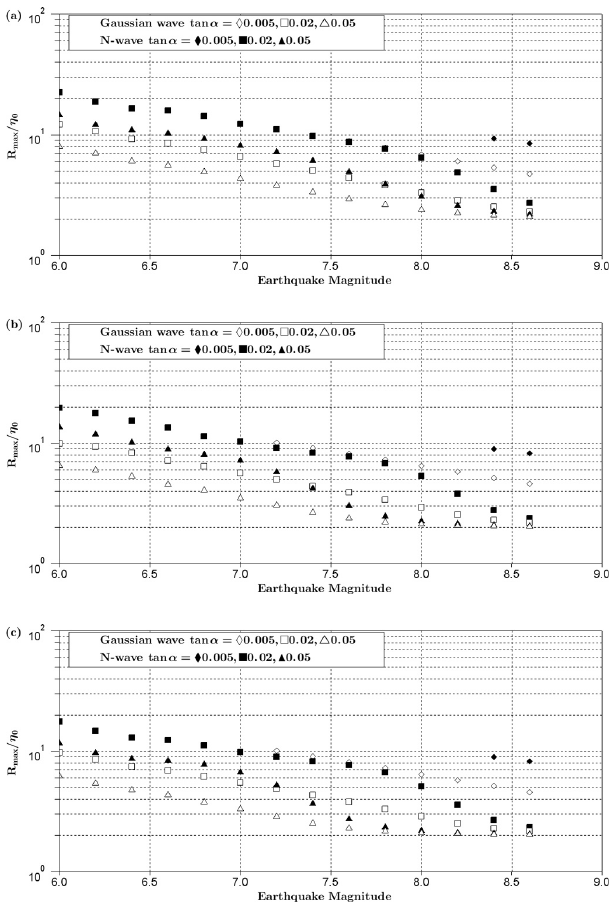
Fig. 4. Run-up amplification factor for Gaussian impulses and N wave impulse x 0 = 40km (tan α = 0 . 005), x 0 = 10km (tan α = 0 . 02), x 0 = 4km (tan α = 0 . 05), h 0 = 4000m, and h 1 = 200m for different inclinations of continental shelf and continental slope: (a) tan β = 0 . 1 ( x 2 = 40km), (b) tan β = 0 . 5 ( x 2 = 8km), and (c) tan β = 3 ( x 2 = 1 .